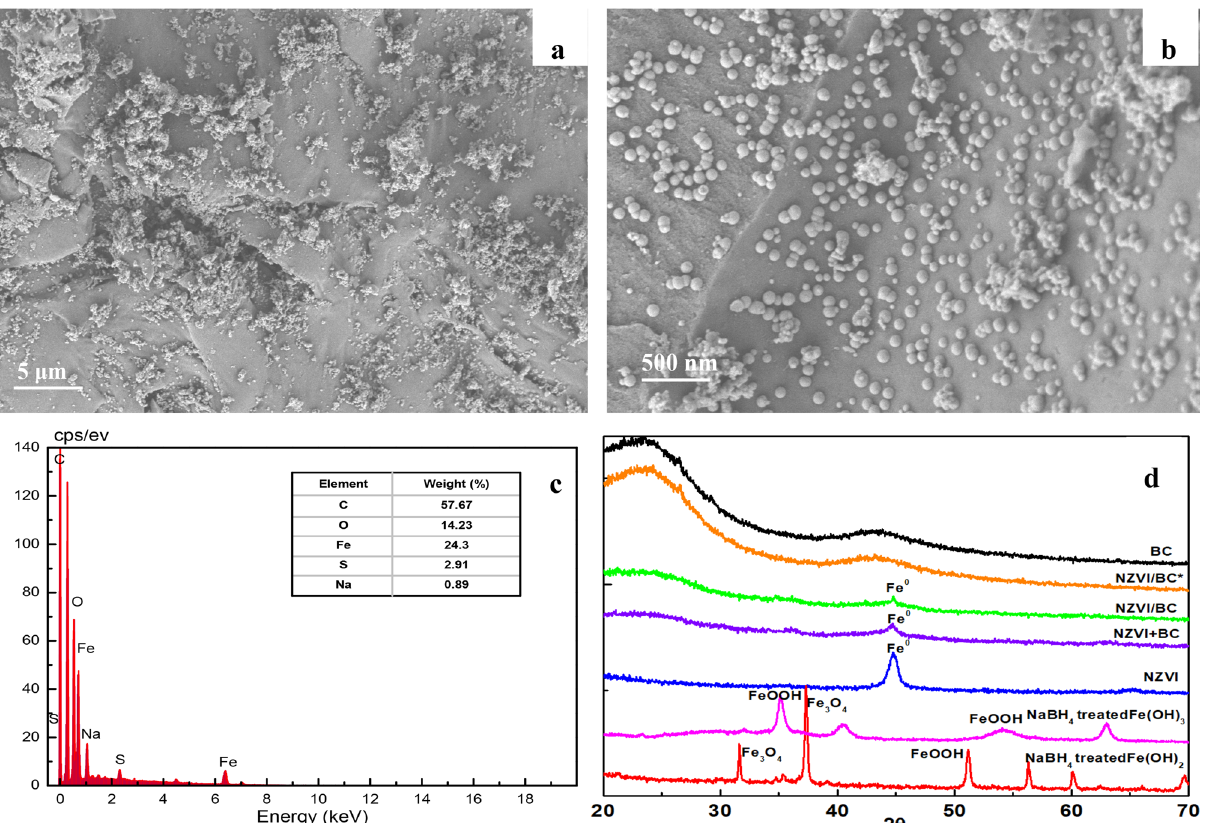
Figure3. SEM images ( a , b ) and EDX ( c ) spectrum of NZVI/BC, as well as XRD patterns ( d ) of BC, NZVI/BC, NZVI/BC*, NZVI + BC, NZVI,